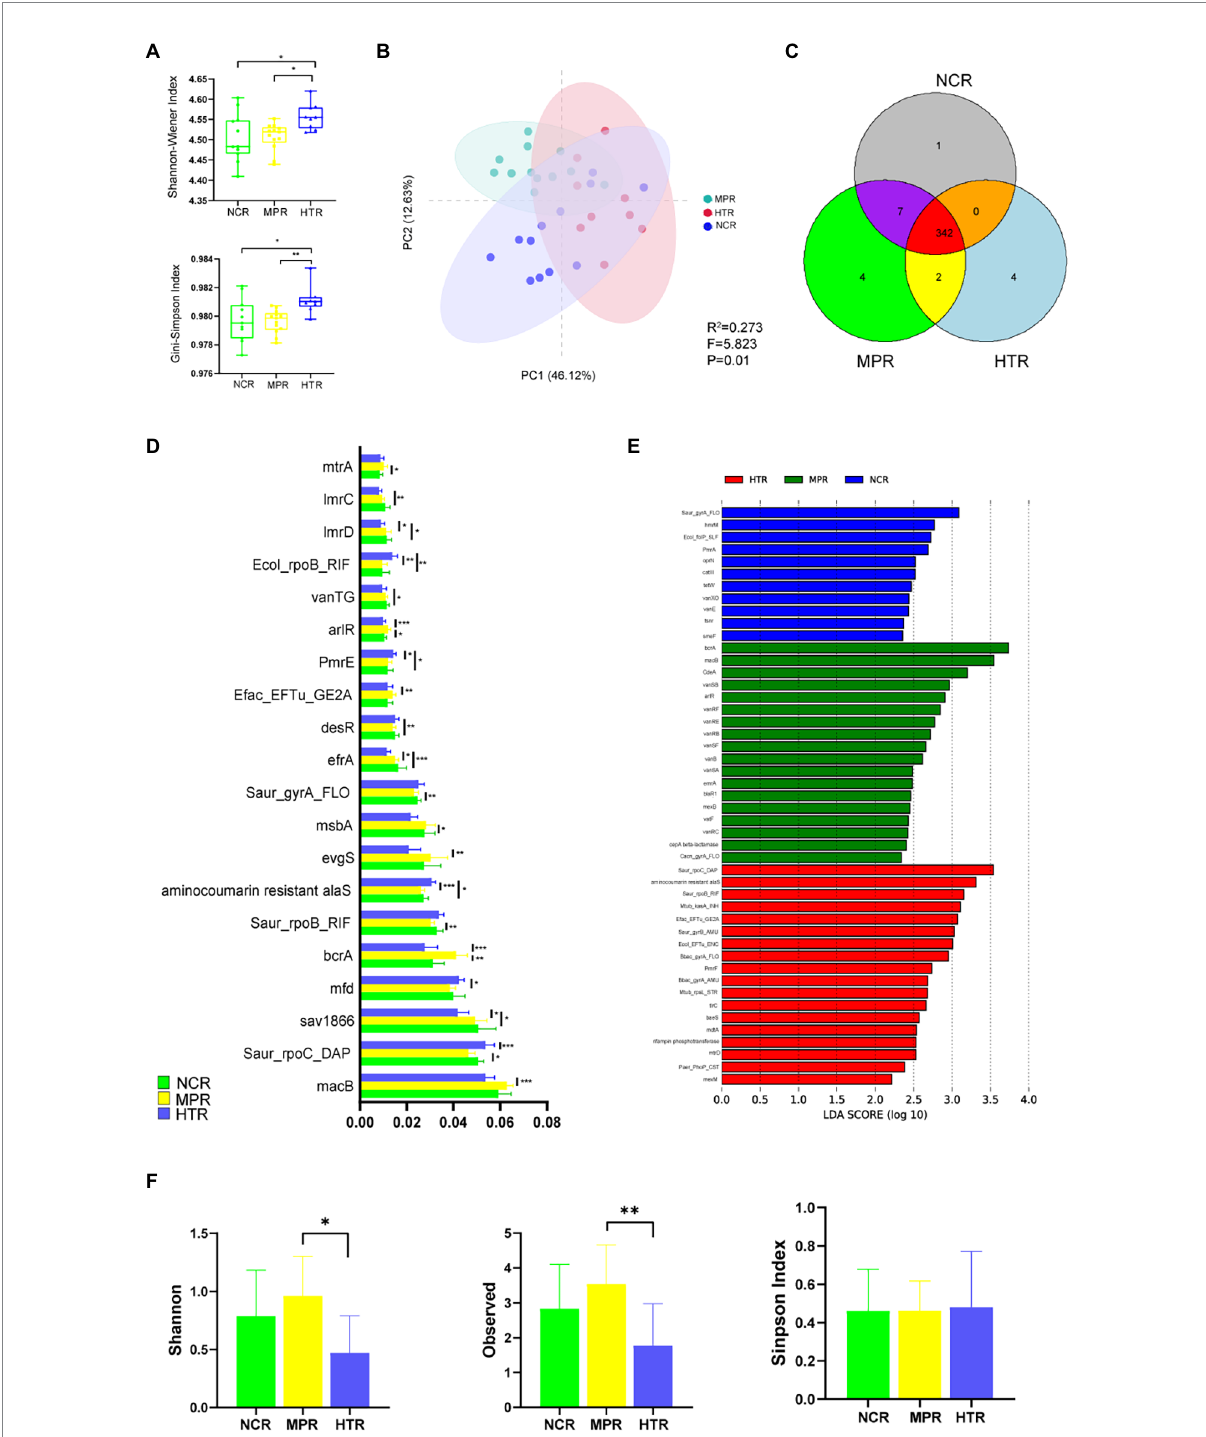
FIGURE 4 The alpha diversity of ARGs in the three study sites. (A) Shannon–Wiener and Gini–Simpson indices. (B) Bray–Curtis dissimilarity of gut microbial community composition between the three study sites; ellipses with 95% confidence intervals are displayed for the PCoA. (C) Shared ARGs between the NCR, MPR, and HTR. (D) Comparison of the main ARGs. (E) Difference in ARG abundance by LEfSe ( p < 0.05 and LDA > 2). (F) Alpha diversity of plasmids in the three study sites according to observed species richness, Shannon–Wiener, and Gini–Simpson indices. * p < 0.05; ** p < 0.01; *** p <